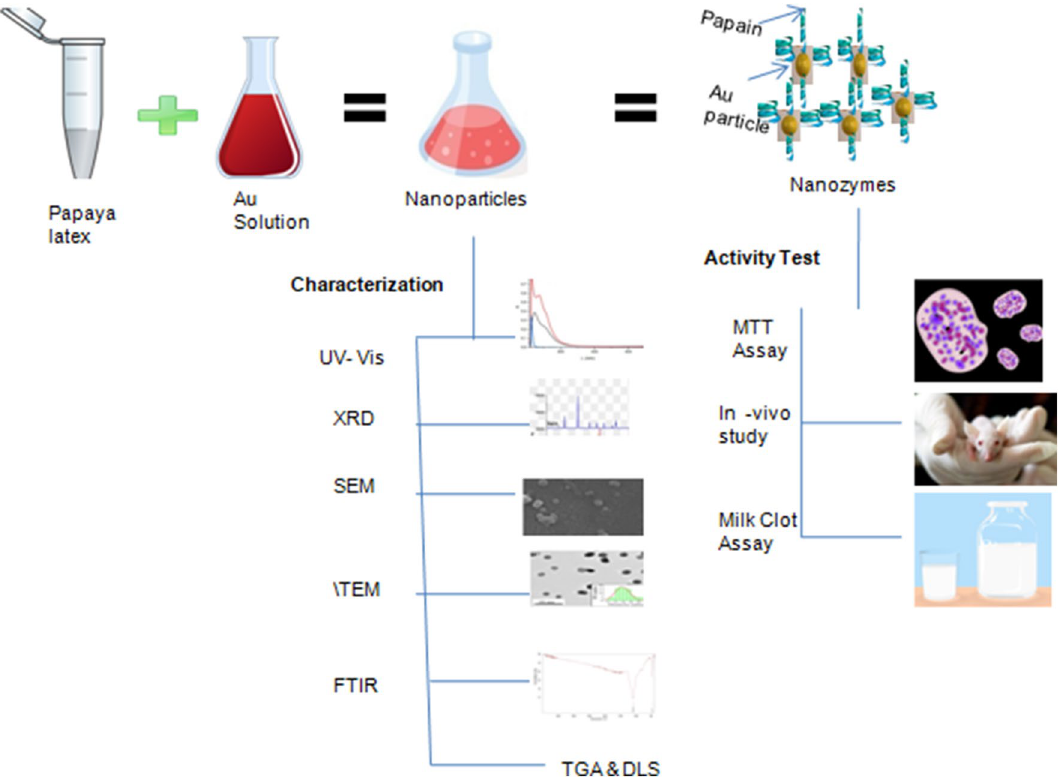
Figure 12. Schematic representation of synthesis of nanoparticles, its characterization (UV–VIS, XRD, SEM, TEM, FTIR, TGA, DLS) and activity tests (MTT test, in-vivo study and Milk Clot